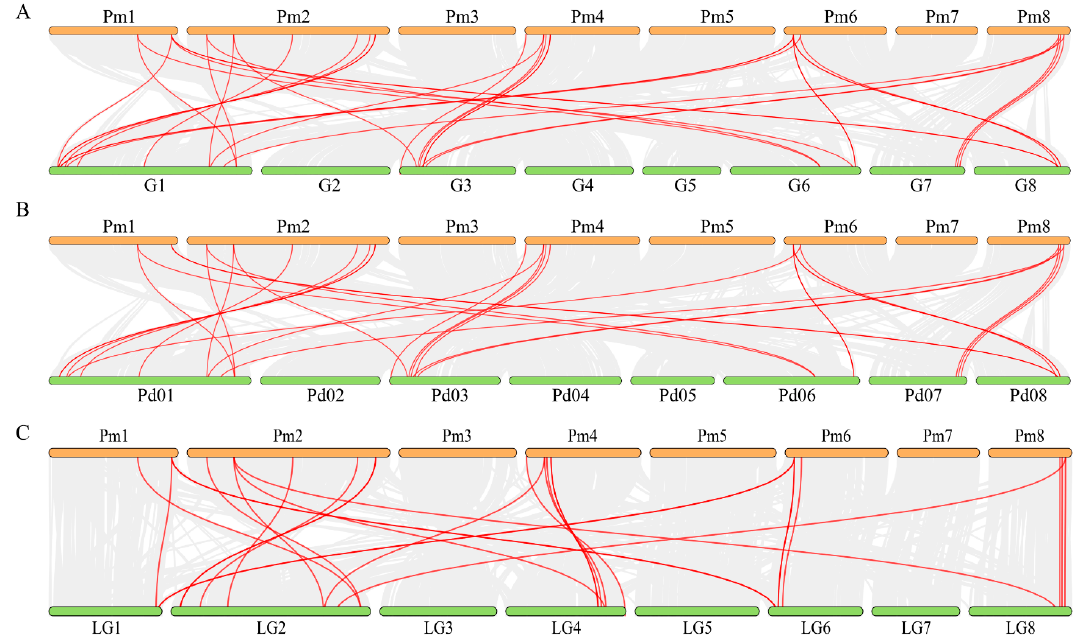
Figure 5. Synteny analyses of Aux/IAA genes. ( A ) Synteny analyses in P. mume and P. persica (Pp). ( B ) Synteny analyses in P. mume and P. dulcis (Pd). ( C ), Synteny analyses in P. mume and P. armeniaca (Pa). Red line means orthologous gene pair. Gray line indicates collinear blocks within P. mume and other Rosaceae plant genomes. Red line implies orthologous gene pair. Chromosomal names with prefixes ‘Pm’, ‘G’, ‘Pd’, and ‘LG’ indicate P. mume , P. persica , P. dulcis , and P. armeniaca , respectively. The selection pressure of gene duplications was calculated by using the mutation rates of Ka (nonsynonymous) versus Ks (synonymous). As shown in Table 2, all the Ka/Ks values of duplicated RoIAA pairs were under 1.0 and ranged from 0.097 to 0.344, indicating a strong purifying selection during RoIAAs expansion. The divergence time of Syntenic Gene Type of Ka Pairs Duplication the duplicated pairs of RoIAAs ranged from 44.48 to 108.54 million years (Mya). Table 2. Pairwise comparison of Ka/Ks values of RoIAA genes in four Rosaceae species.